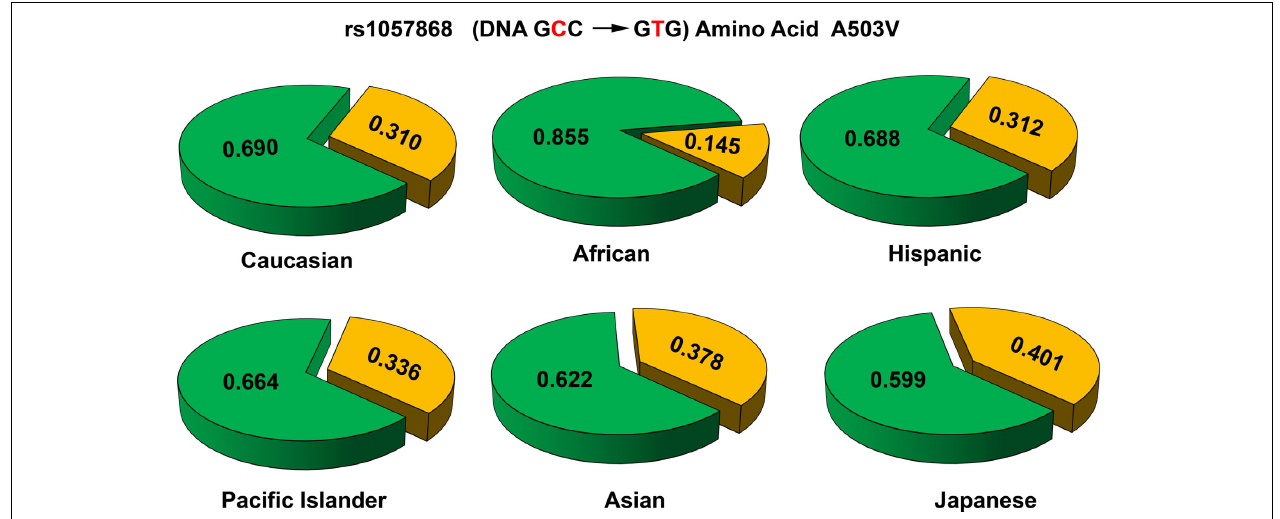
FIGURE 7 | Allele frequencies of POR variant A503V in different population groups. The p.A503V variant of POR (rs1057868) is most common across all population groups. In various sequencing studies specifically targeting POR gene as well as large scale sequencing projects the POR p.A503V is present as most common minor allele. The average minor allele frequency in different studies ranges from 0.25 to 0.45. A closer look at the data revealed some differences. In the Caucasian and Hispanic